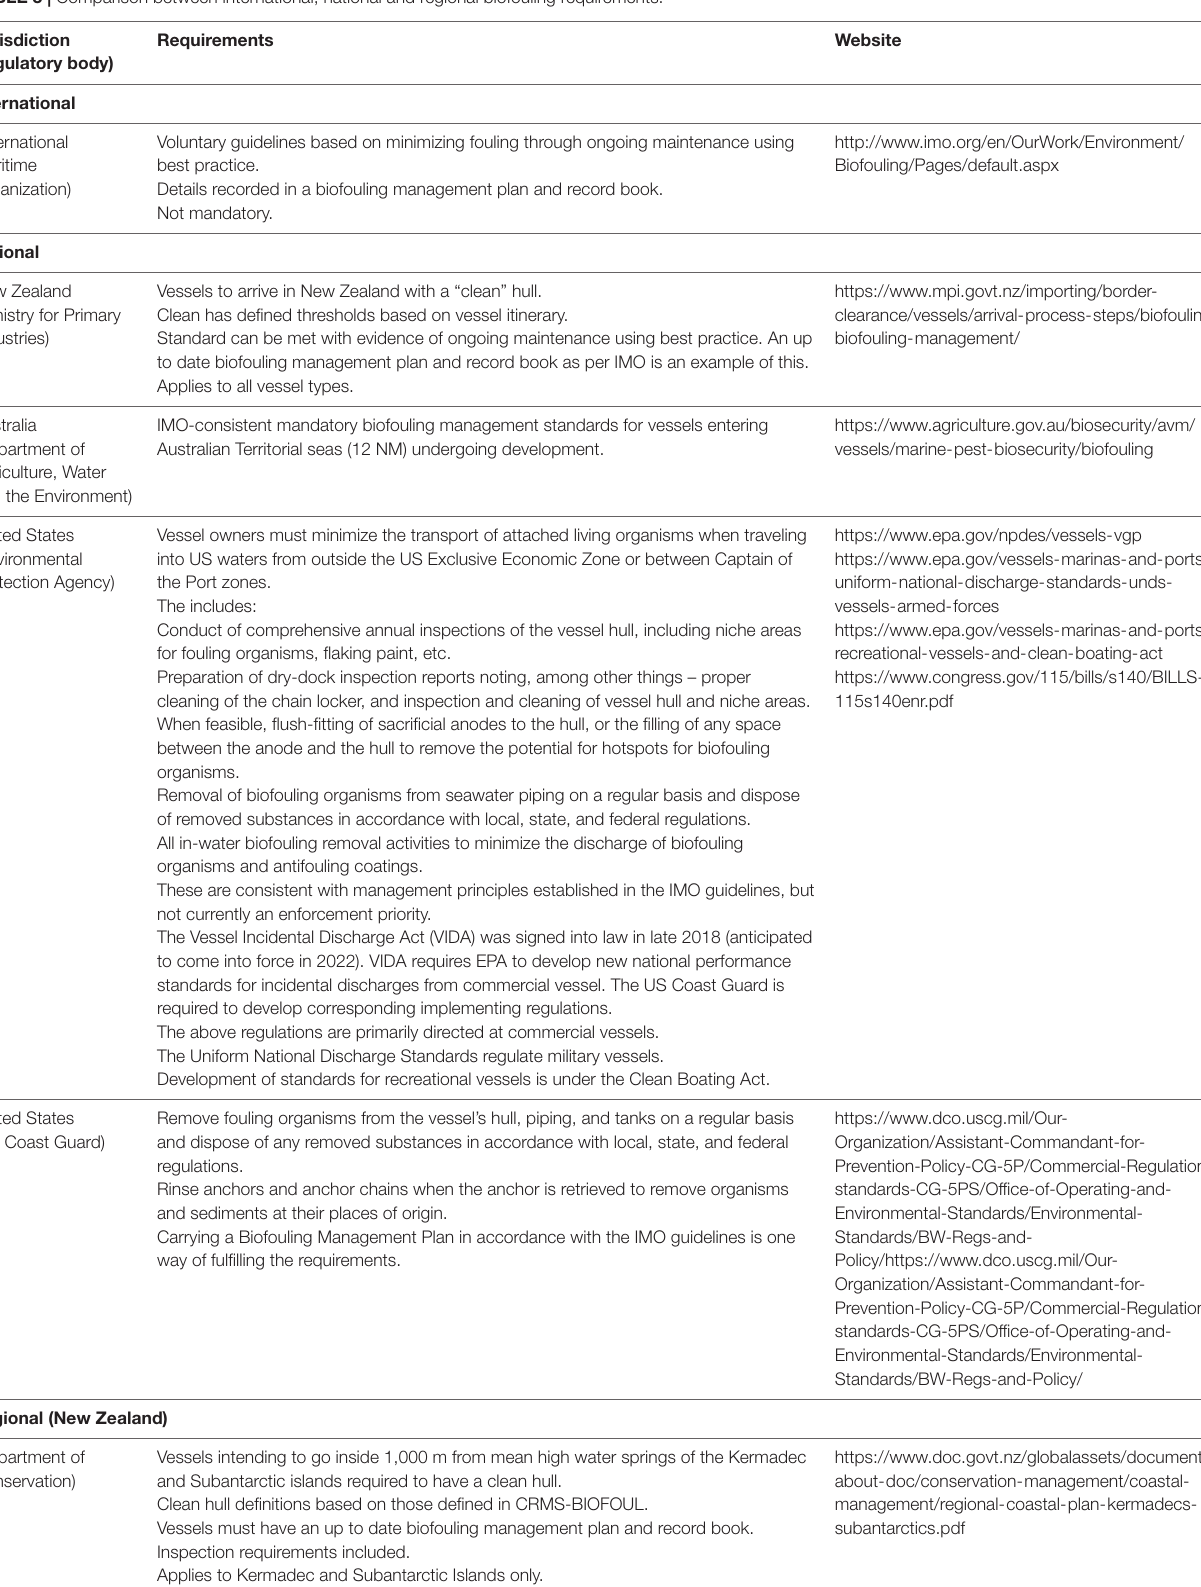
TABLE 3 | Comparison between international, national and regional biofouling